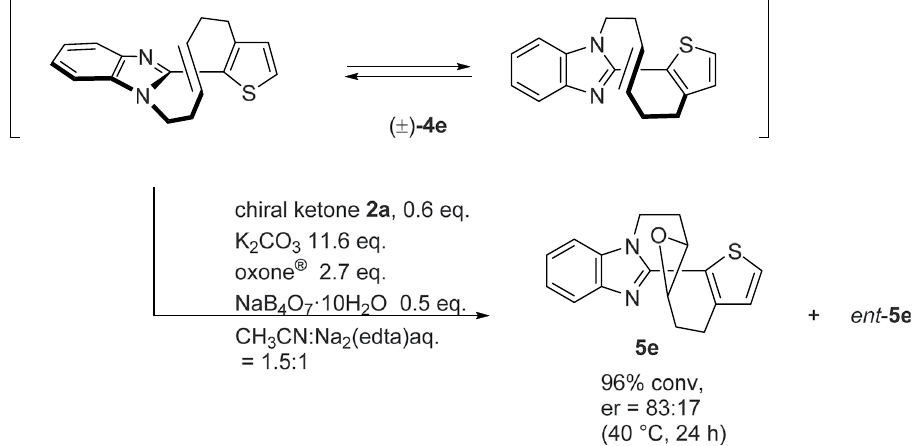
Figure 7. Scheme on the dynamic kinetic resolution of winding-vine shaped heterobiaryl 4e with Shi’s